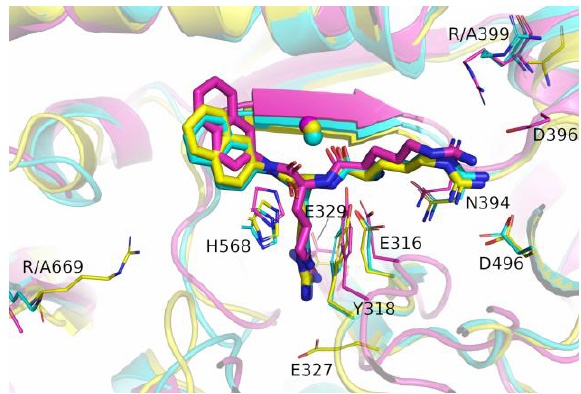
Figure 5. Binding of Arg 2 -2NA in the binding site of the wild-type (cyan) and the mutated (R399A in yellow and R669A in magenta) DPP III enzymes. Shown are optimized structures obtained after 1 µs of MD simulations. The mutated amino acids and the amino acid residues that form polar interactions/hydrogen bonds with the ligand are shown as thin sticks. The β -sheet (residues A388- N391) from the lower protein domain involved in antiparallel binding of the ligand is shown as an opaque cartoon. The zinc ion is shown as a sphere.